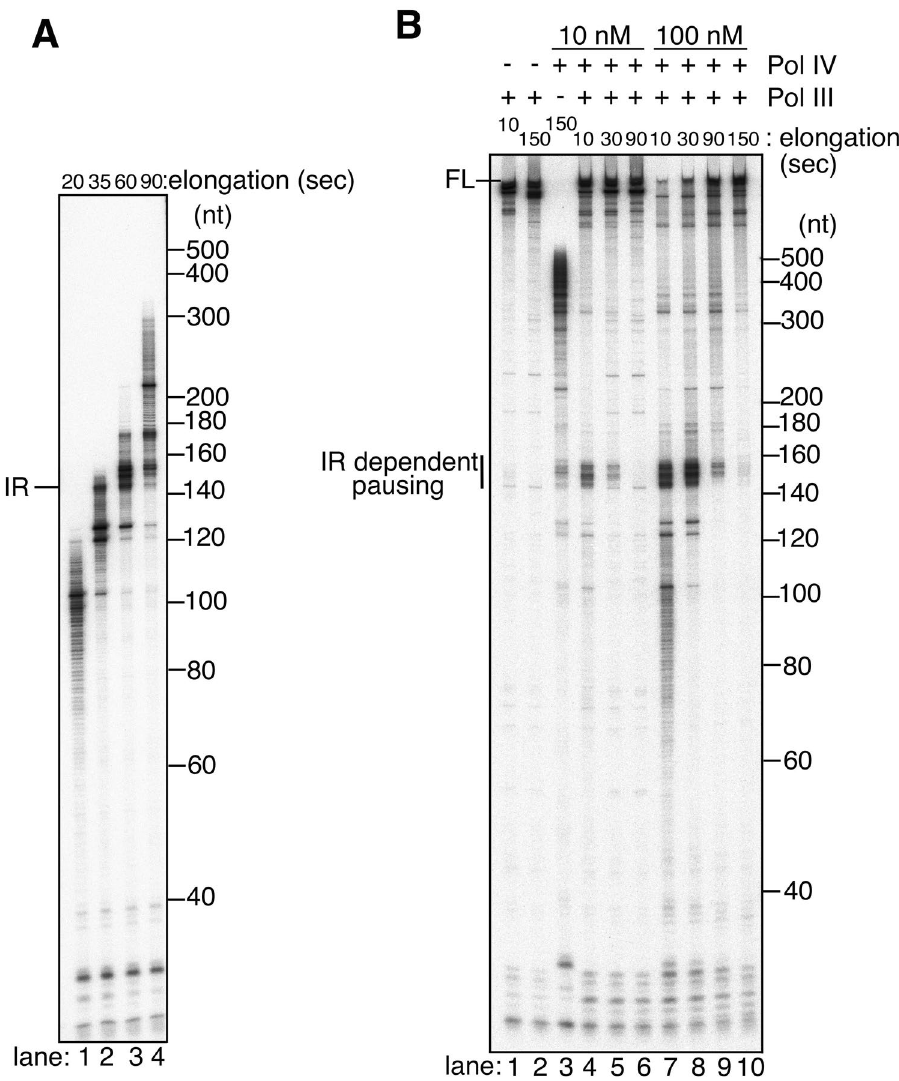
Figure 5. Two sequential polymerase switches rapidly take place to replicate across the hairpin structure by Pol III and Pol IV. ( A ) The behavior of Pol IV- β complex was analyzed on primed pMS2-aIR-23. The γ complex loads the β clamp onto template DNA instead of Pol III. Pol IV bound to the β clamp solely elongates the primer for indicated time. See Materials and Methods for details. ( B ) The effect of Pol IV on Pol III was tested on primed pMS2-aIR-23 in the time course experiment. Wild-type Pol IV was added at a final concentration of 10 nM (lanes 4–6) or 100 nM (lanes 7–10) together with Pol III. Replication products at indicated time points were analyzed as in Fig. 2B. The amount of pausing and full-length products in Fig. 5B were quantified and the percentages of each product were shown in Supplemental Figure S3A. The quantitative analysis was independently repeated and the averaged data was shown in Supplemental Figure